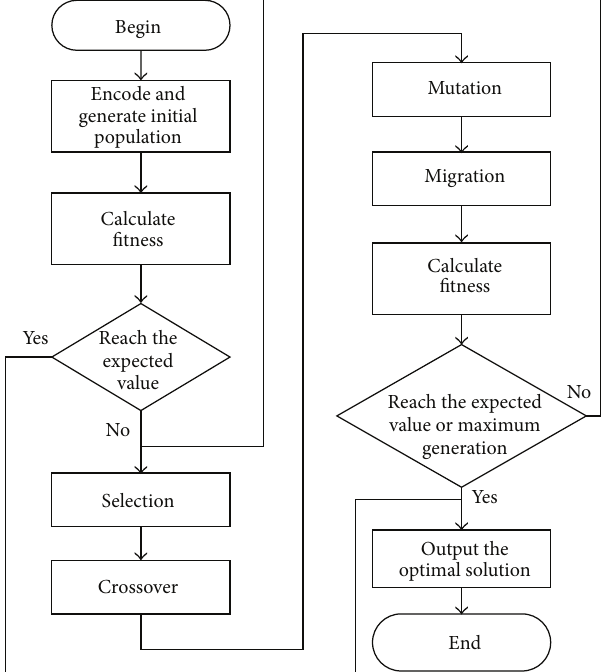
Figure 6: The process of the genetic